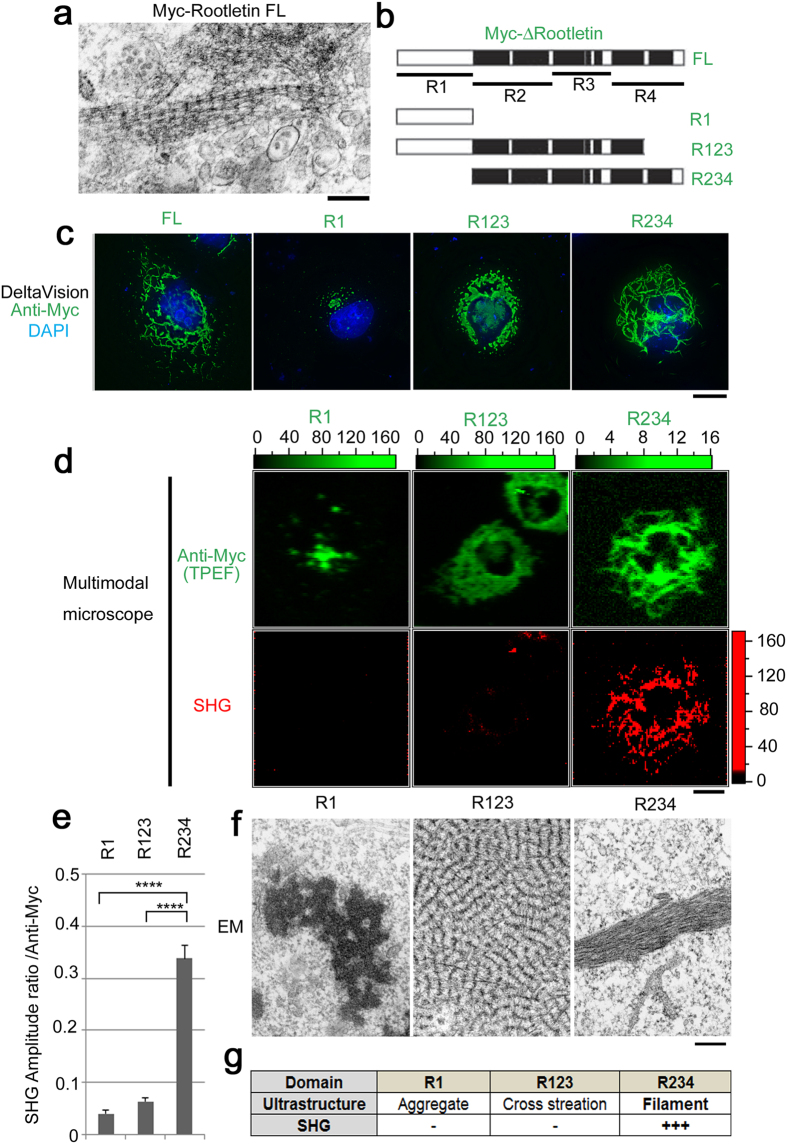
SHG is ascribed to the Rootletin R234 domain, which assembles filaments.Myc-tagged deletion constructs of human Rootletin were introduced into COS7 cells by transfection. Transfectants were fixed and subjected to multiple microscopic observations. (a) Full-length Myc-human Rootletin assembles intact filaments with periodic cross-striation at the electron-microscopic level, like endogenous Rootletin filaments. (b) Schematic diagram of humanized and Myc-tagged Rootletin deletion mutants: R1, Globular head domain; R2-4, rod domains. See also ref. 35. (c) Each human deletion mutant assembles a distinct architecture, as revealed by standard immunofluorescence, as previously reported for the murine case. Note that the minimal filament-forming domain is R234. Anti-Myc (green), DAPI (blue). (d) Multimodal microscopy highlights the correlation of SHG with filament assembled from R234 domain. TPEF (green), SHG (red). (e) Quantitation of the SHG in (d), normalized to Myc intensity per cell. (f) Distinct ultrastructures assembled from each fragment: R1, aggregates with high electron density; R123, massive cross-striation; R234, densely packed filaments. (g) Summary of multilateral domain analyses. Bars, 200 nm in (a and f) and 10 μm in (c and d). Error bars represent s.e.m. ****P < 0.001. N = 5 in (e). Color scales indicate intensity (a.u.).